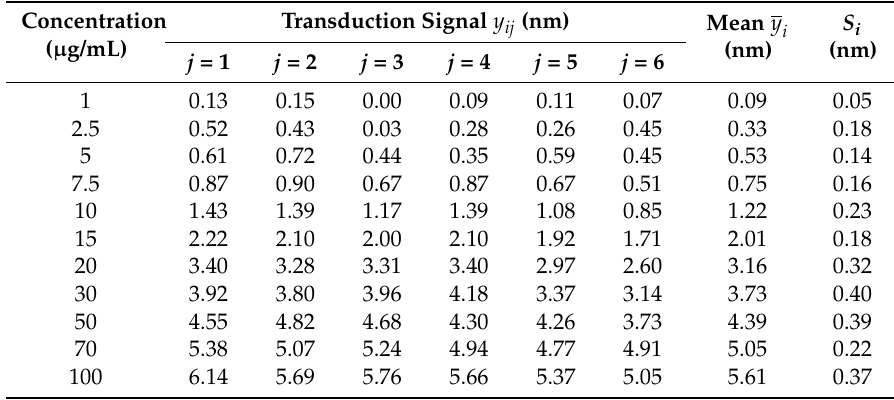
Table 4. Numerical values from calibration of six BICELLs (Biophotonic Sensing Cells) for anti-IgG